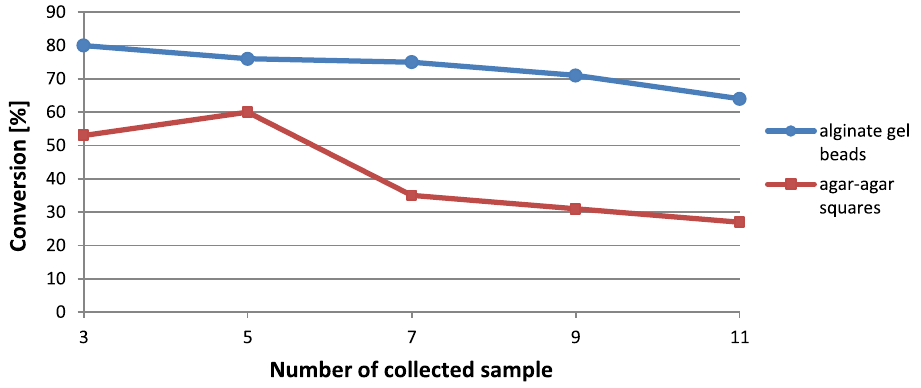
Figure 7. Conversion of massoia lactone ( 1 ) with immobilized cells of E. coli BL21(DE3)/pET30a-OYE3 in semi-continuous flow system with the use of segmented gas–liquid flow.